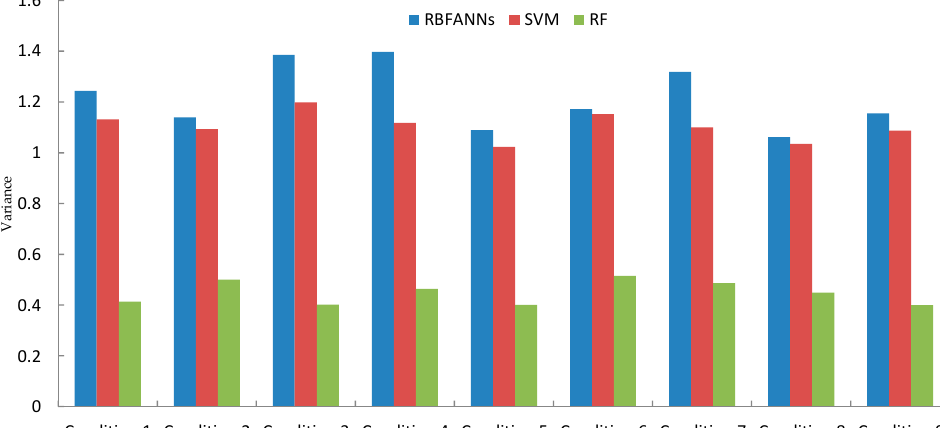
Figure 12. The predicted result variance under different conditions with different classifiers.